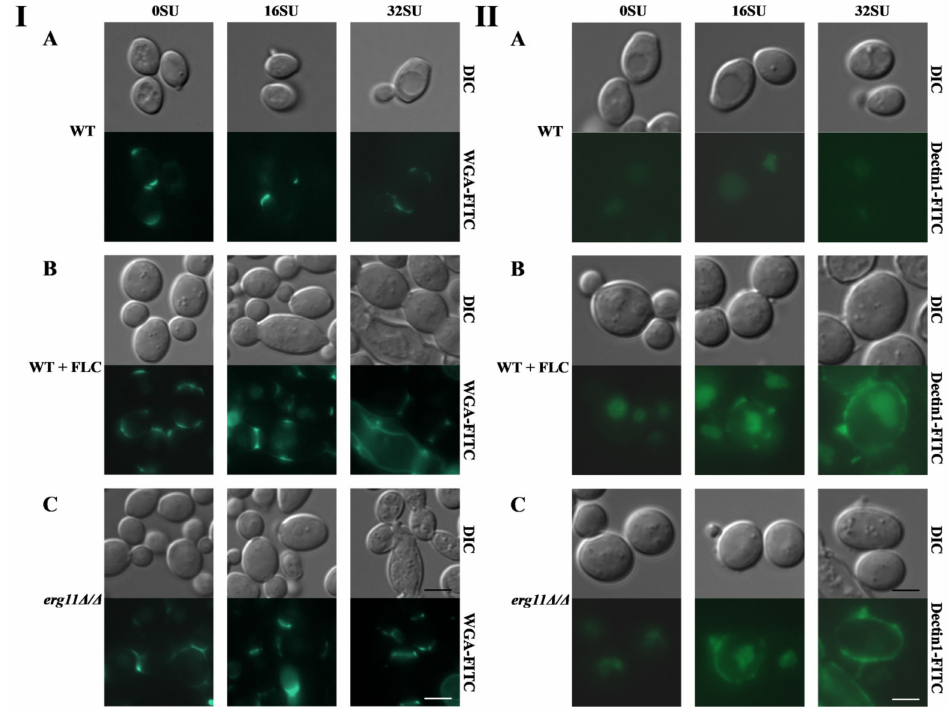
Figure 4. Unmasking chitin was detected by chitin staining with wheat germ agglutinin conjugated to fluorescein isothiocyanate (WGA-FITC) (panel ( I )). Unmasking β -glucan was detected by β -glucan staining with Fc-hDectin-1 (FC-Dec1) and Alexa Fluor 448-conjugated anti-human IgG Fc antibodies (panel ( II )) in C. albicans treated with 16 or 32 µ g / mL SU. ( A ) C. albicans CAF2-1 (WT) strain; ( B ) C. albicans CAF2-1(WT)strainsimultaneouslytreatedwith1 µ g / mLfluconazoleand( C ) C.albicans KS028( erg11 ∆ / ∆ ) mutant. Images are representative of at least three independent experiments. Scale bars are equal to 2.5 µ